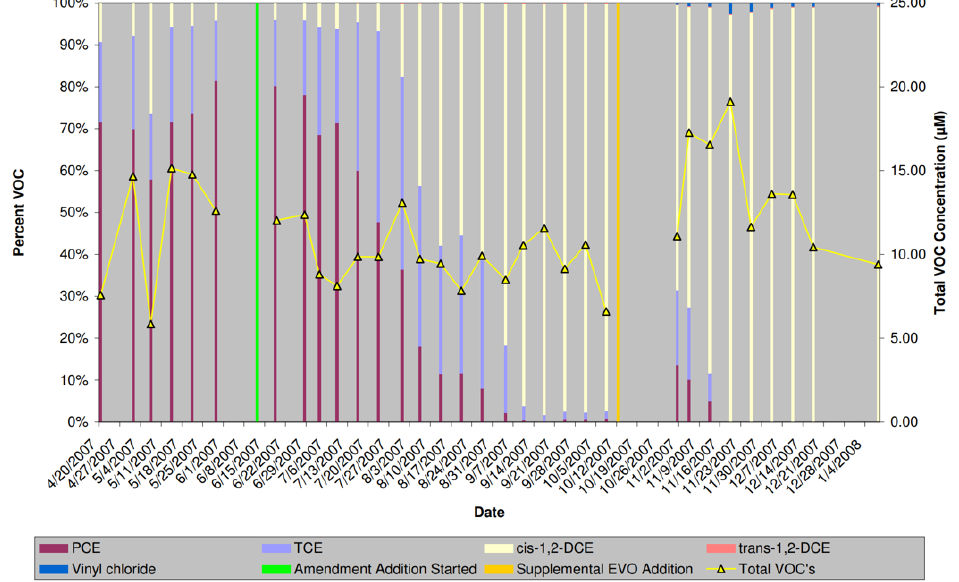
Figure 5. Comprehensive test cell data summary: Ethyl lactate/EVO, HSE-11/HSI-14, HSE-11% VOC, and total VOC concentration.